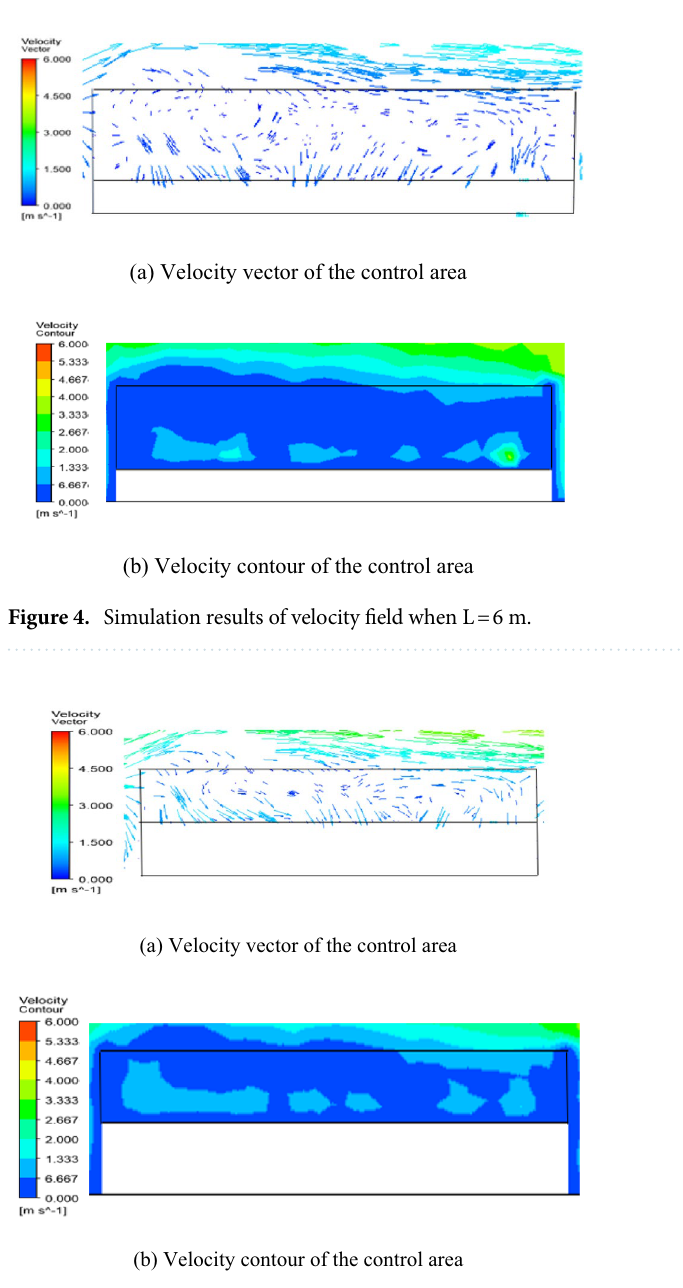
Figure 5. Simulation results of velocity field when L = 11